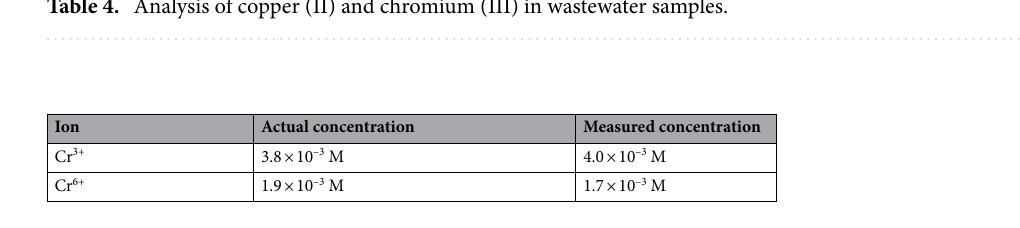
Table 5. Determining the trivalent and hexavalent chromium in standard sample.